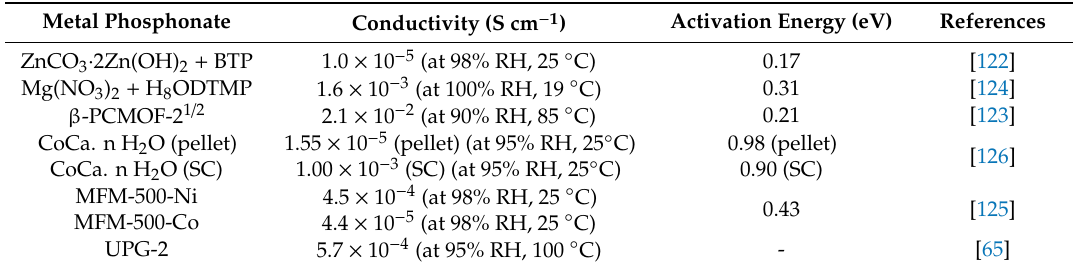
Figure 10. ( a ) Proton conductivity of the single crystals of CoCa · nH 2 O measured along di ff erent directions at 25 ◦ C upon increasing (filled) or decreasing (open) humidity. The conductivity of the pellet sample is also shown for comparison; ( b ) plots of log( σ T) versus 1000 / T for bulk and single crystal samples of CoCa · 4H 2 O at 95% relative humidity. The solid lines represent the best fit of the data. Nyquist plots for CoCa · nH 2 O at 95% RH and various temperatures; ( c ) bulk sample; and ( d – f ) single crystal sample along the [010], [202], and [201] directions, respectively. Reprinted with permission from [126]. Copyright (2016), American Chemical Society. Table 3. Summary of proton conduction in the phosphonate frameworks.